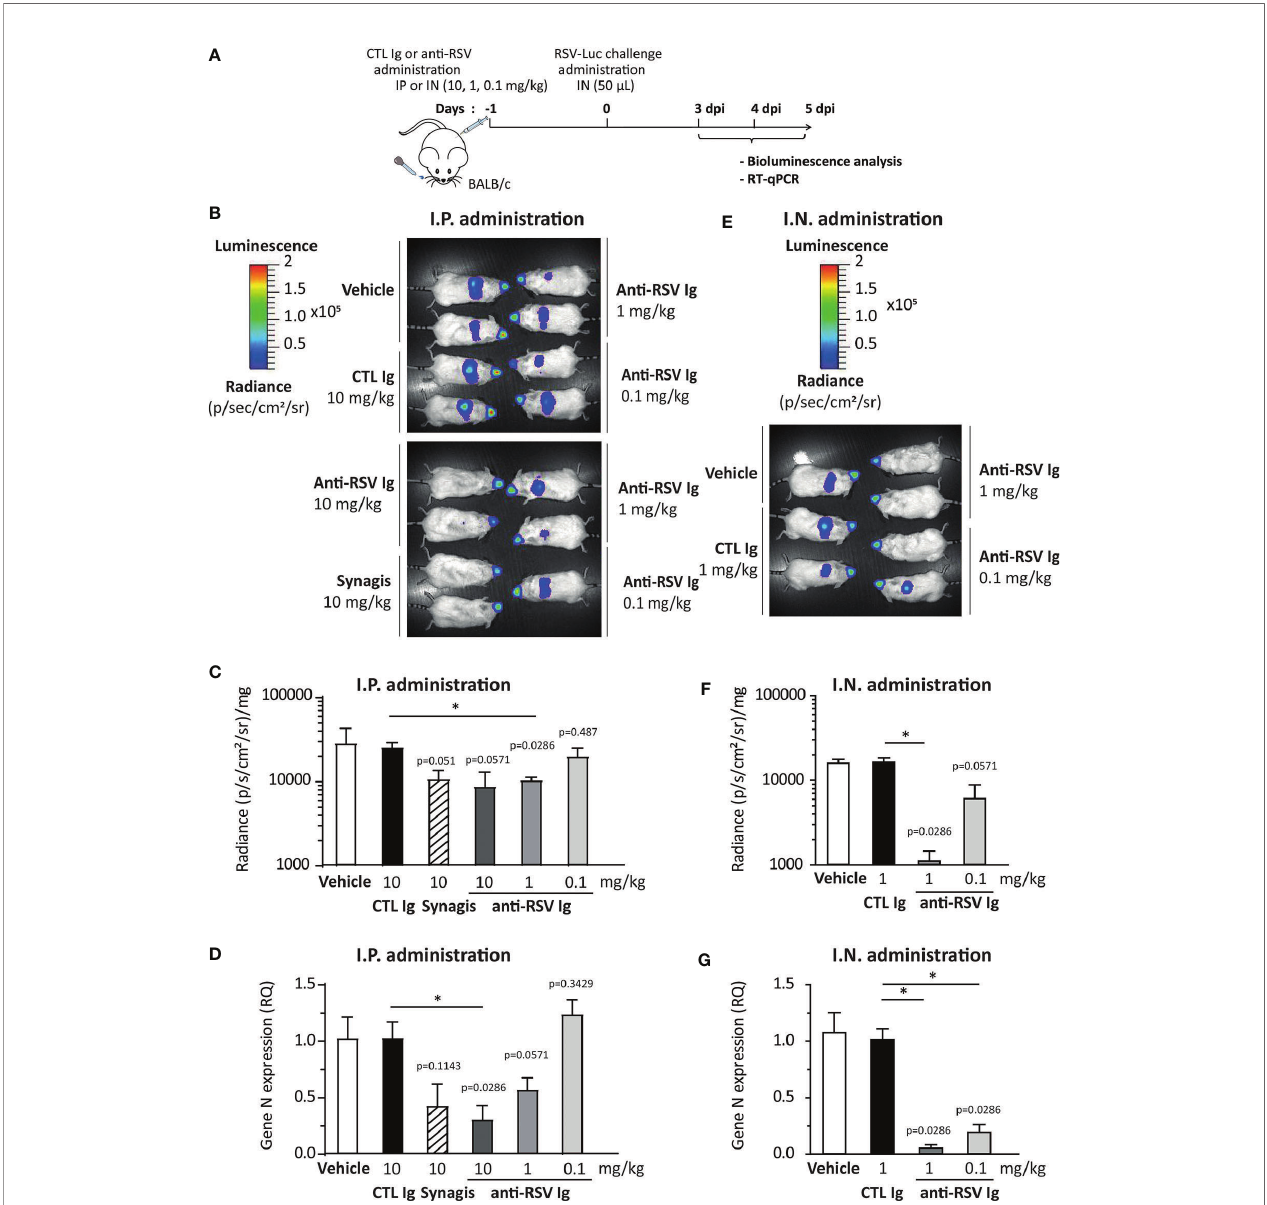
FIGURE 3 | Evaluation of the protective ef fi cacy of anti-RSV Ig in mouse infection model. (A) Experimental design showing the time and mode of RSV Ig delivery as well as the time of infection with RSV-Luc and the follow up of virus replication. (B – D) BALB/c mice received I.P. administration of 0.1, 1 or 10 mg/kg of anti-RSV Ig or 10 mg/kg of Synagis ® before intranasal infection with RSV-luciferase (7 x 10 5 pfu, 50 µL). As a control of protection/infection, mice were respectively treated with CTL Ig (10 mg/kg) or vehicle. (E – G) BALB/c mice received I.N. administration of 0.1 or 1 mg/kg of anti-RSV Ig (50 µL) before intranasal infection with RSV-luciferase (7 x 10 5 pfu, 50 µL). As a control of protection/infection, mice were respectively treated with CTL Ig (1 mg/kg) or vehicle. (B, E) In vivo bioluminescence intensity was evaluated at 3, 4 and 5 d.p.i. with IVIS imaging system and is shown at 4 d.p.i. in this fi gure (dorsal view detection). Depicted images are representative of 2 independent pictures. (C, F) In vitro luciferase activity was measured in lung homogenates by quanti fi cation of bioluminescence emission (radiance in photon/sec/cm 2 /sr) using “ Living Image ” software after addition of D-luciferin to the lysates, and was normalized to the organ weight. Data are mean ± SEM from n = 4 mice. (D, G) mRNA level of RSV N gene was evaluated by real time RT-PCR in the lungs. Data are mean ± SEM from n = 4 mice. Signi fi cance is represented on graphs: *P <